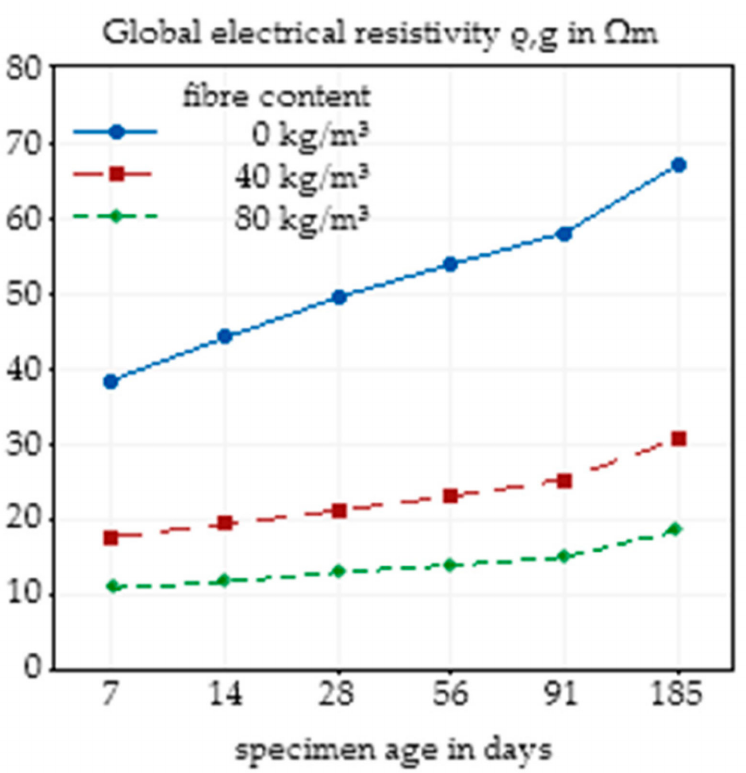
Figure 13. Effect of the concrete age on the global electrical resistivity of SFRC depending on the fibre content based on nine